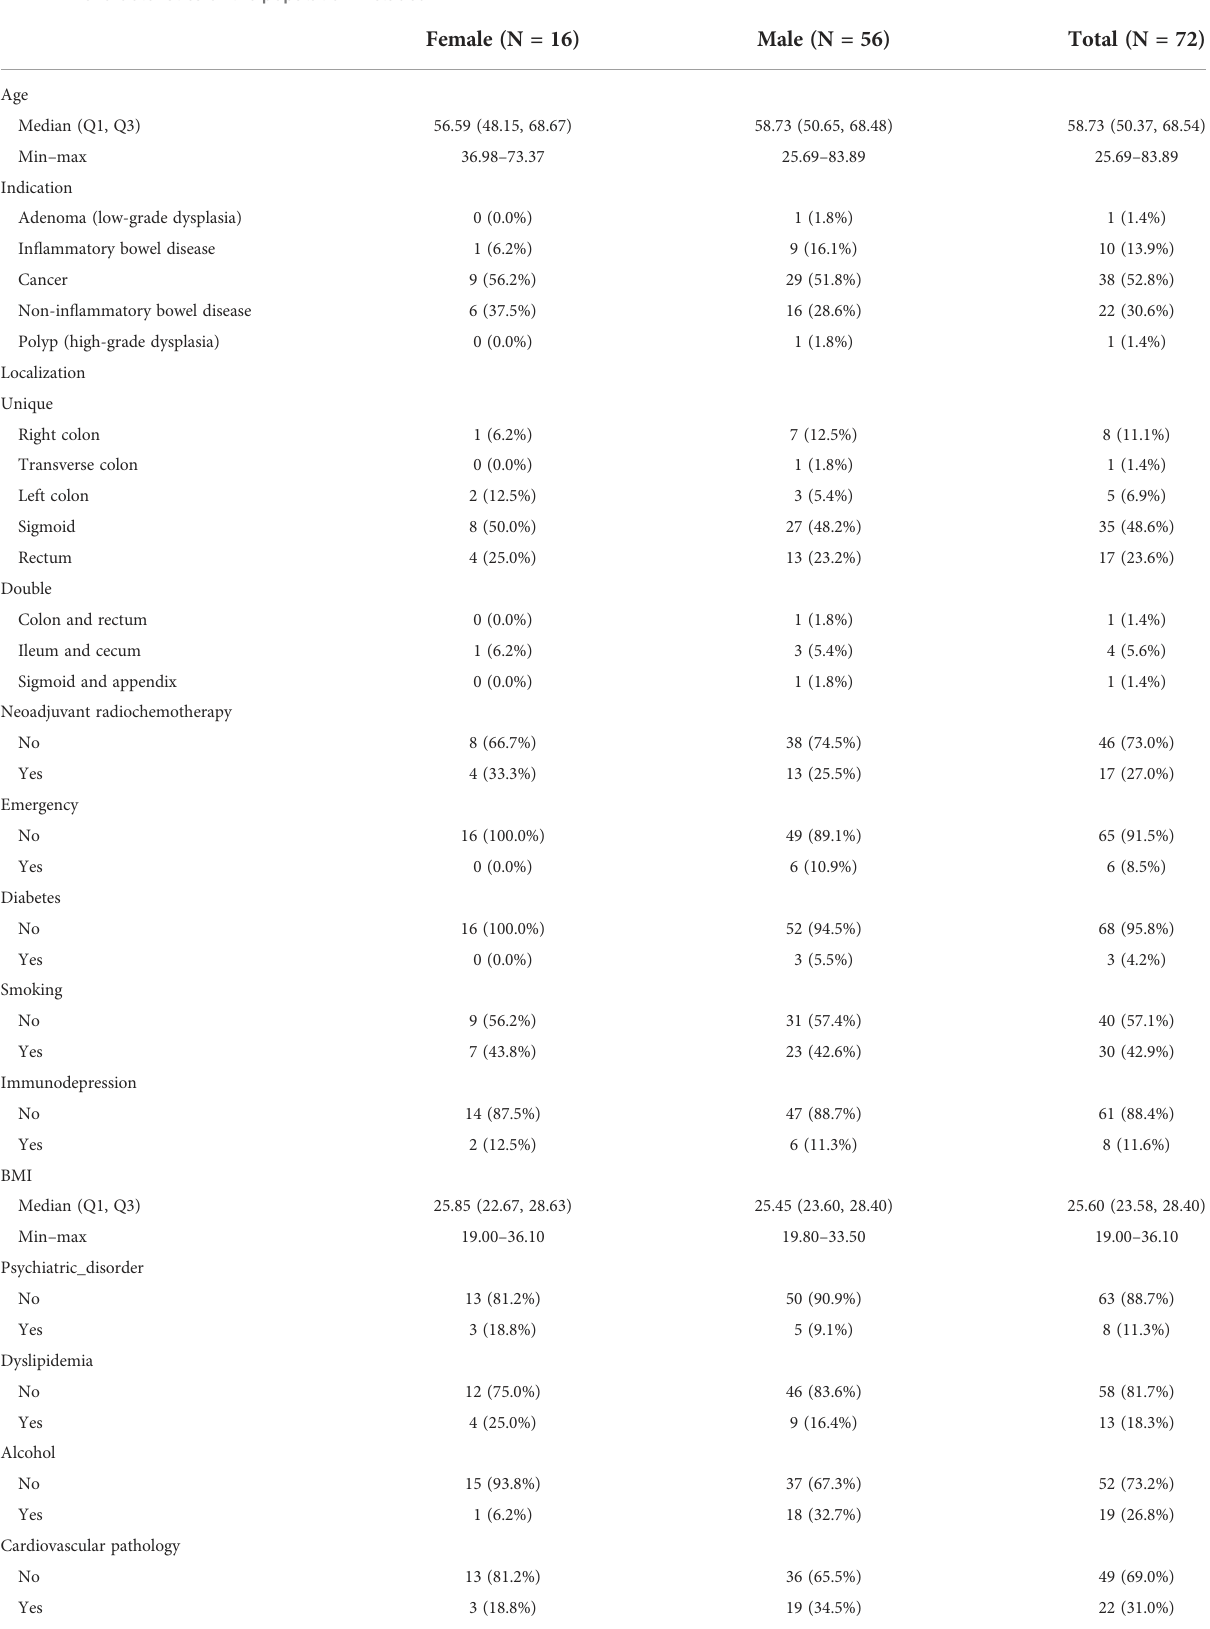
TABLE 1 Characteristics of the population